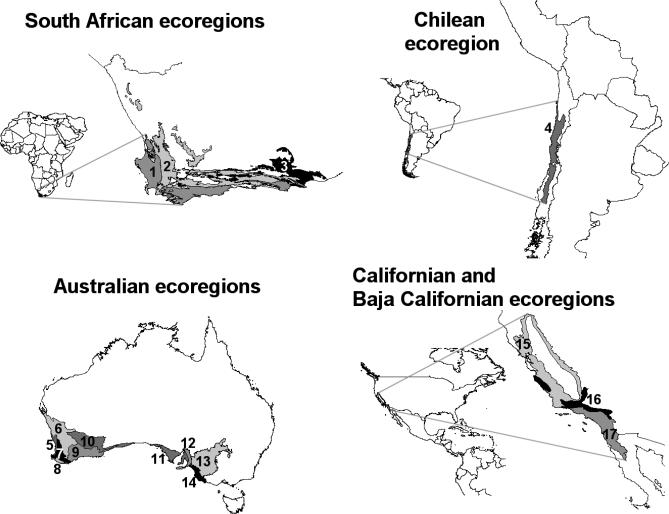
The Mediterranean Ecoregions of South Africa, Chile, Australia, and California/Baja CaliforniaLowland fynbos and renosterveld (1), montane fynbos and renosterveld (2), Albany thickets (3), Chilean matorral (4), Swan Coastal Plain scrub and woodlands (5), Southwest Australia savanna (6), Southwest Australia woodlands (7), Jarrah-Karri forest and shrublands (8), Esperance mallee (9), Coolgardie woodlands (10), Eyre and York mallee (11), Mount Lofty woodlands (12), Murray-Darling woodlands and mallee (13), Naracoorte woodlands (14), interior chaparral and woodlands (15), montane chaparral and woodlands (16), and coastal sage scrub and chaparral (17).